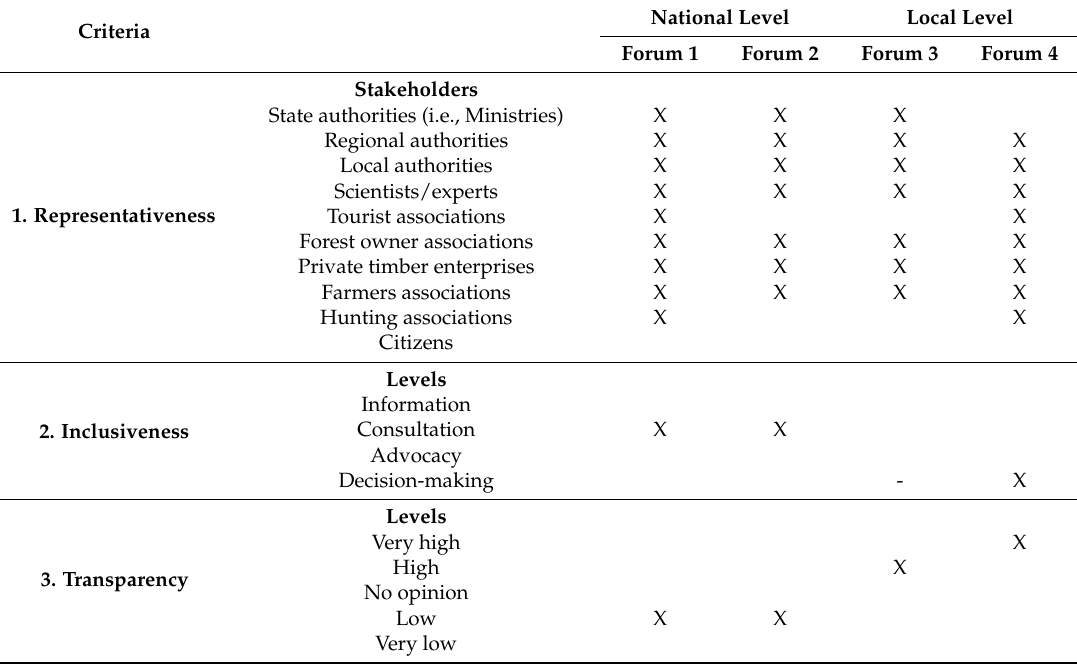
Table 3. Qualitative-based evaluation of stakeholders’ participation in forest-related policy processes in selected cases studied in